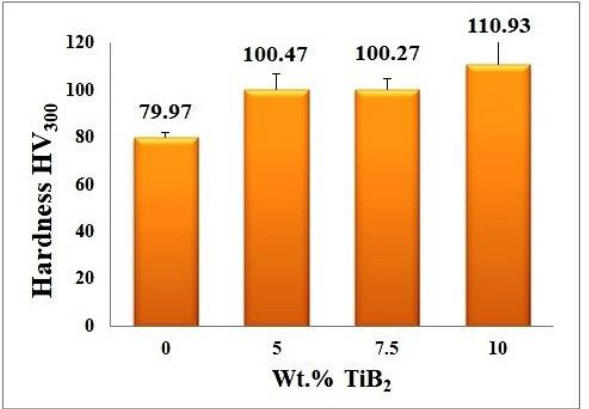
Figure 4: Effect of hardness for different wt.% of TiB 2